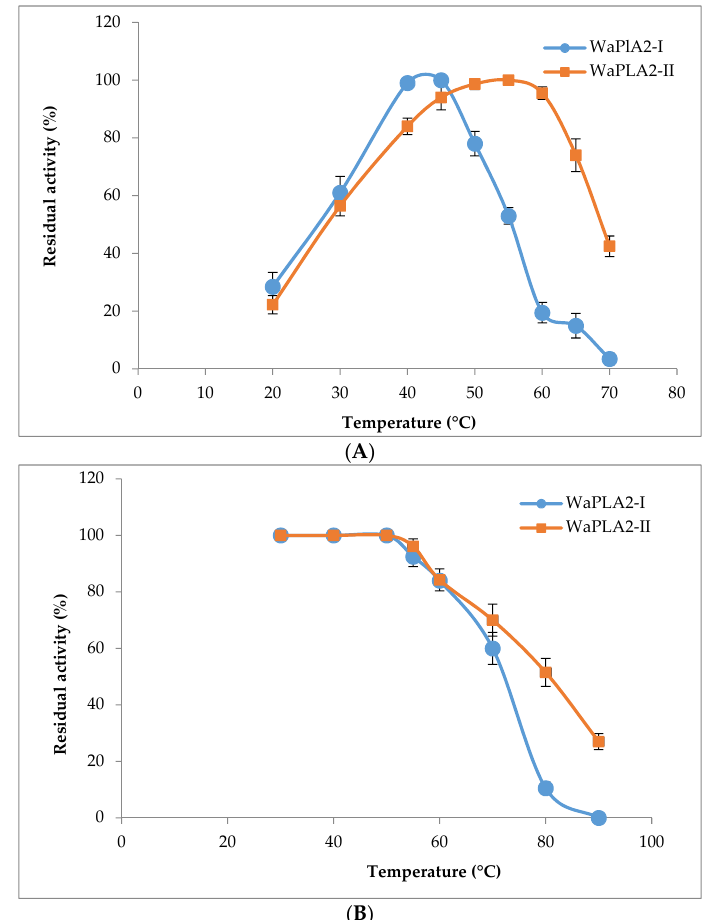
Figure 3. Temperature profile ( A ) and thermal stability ( B ) of the purified Wa PLA 2 -II and -I from the venom of W. aegyptia . Enzyme activity was measured at different temperatures ranging from 20 to 70 °C at pH 9.5, using phosphatidylcholine (PC) as a substrate in the presence of 10 mM Ca 2+ and 4 mM NaTDC (sodium taurodeoxycholate). The activity of the Wa PLA 2 -II at 55 °C was considered as 100%. For thermal stability, the enzymes were incubated at the indicated temperatures (30–90 °C) for 60 min. Residual enzyme activity was assayed under standard assay conditions. The control represents 100% of PLA2 activity at 10 mM Ca 2 + under the same conditions. The results represent the means of three independent experiments and expressed as the mean ± SD (n =